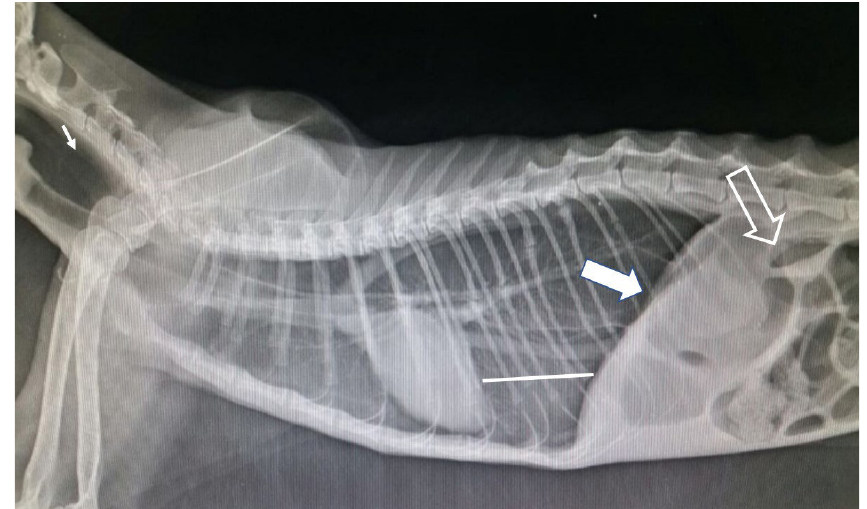
Figura 1. Imagem radiográfica de tórax do paciente relatado, na posição latero-lateral, evidenciando retificação do diafragma (seta cheia), aumento da distância da silhueta cardíaca e cúpula diafragmática (linha branca),